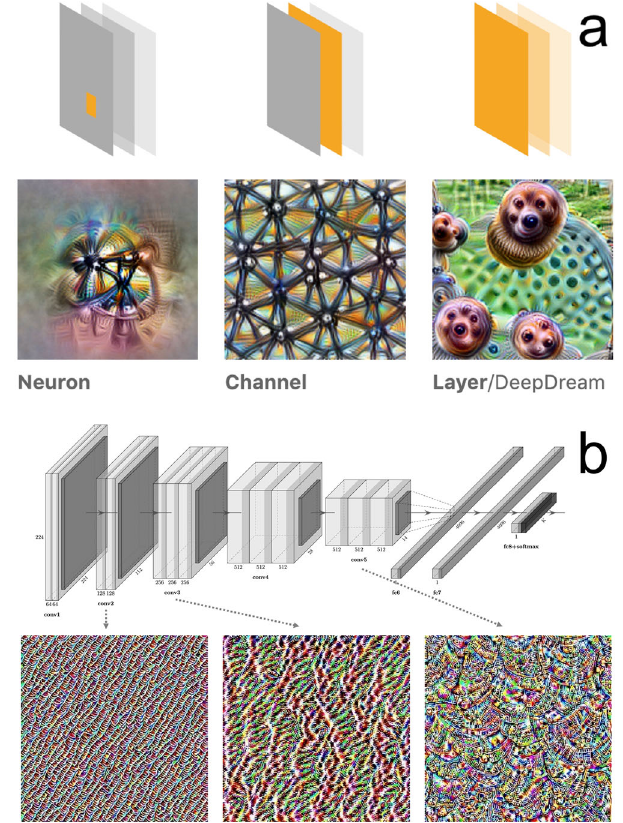
Fig. 9 Illustration of the hierarchical feature representation within CNNs. a Comparison of concepts contained in different network levels (neuron, channel, and layer) 158 . Figure reprinted from ref. 158 under the CC BY 4.0 license 156 . b Visualization of CNN fi lters from different layers of an imageNet 96 pretrained VGG16 network 97 . Note that the fi lter representations become more and more complicated as fi lter positions move deep along the network. The early layer fi lter representations are relatively primitive, while the top layer fi lter representations are highly complicated. The VGG16 architecture is plotted using the plot neural net 159 library. Filter representations are visualized using the convolutional neural network visualizations 150